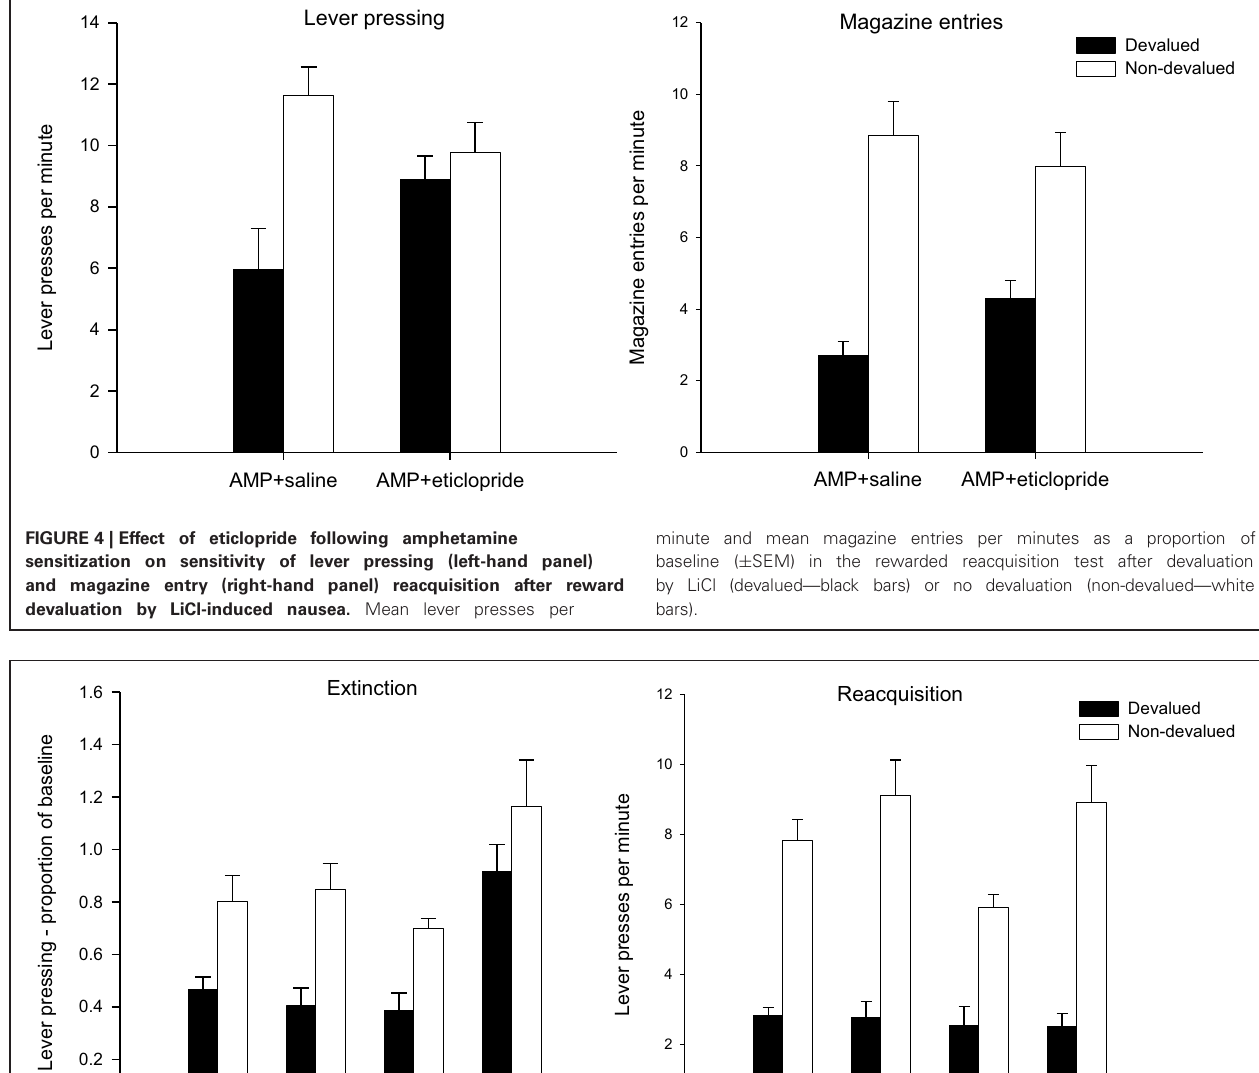
FIGURE 5 | Effect of α -flupenthixol, SCH23390 and eticlopride on sensitivity of lever pressing to reward devaluation by LiCl-induced nausea. Mean lever presses per minute as a proportion of baseline ( ± SEM)